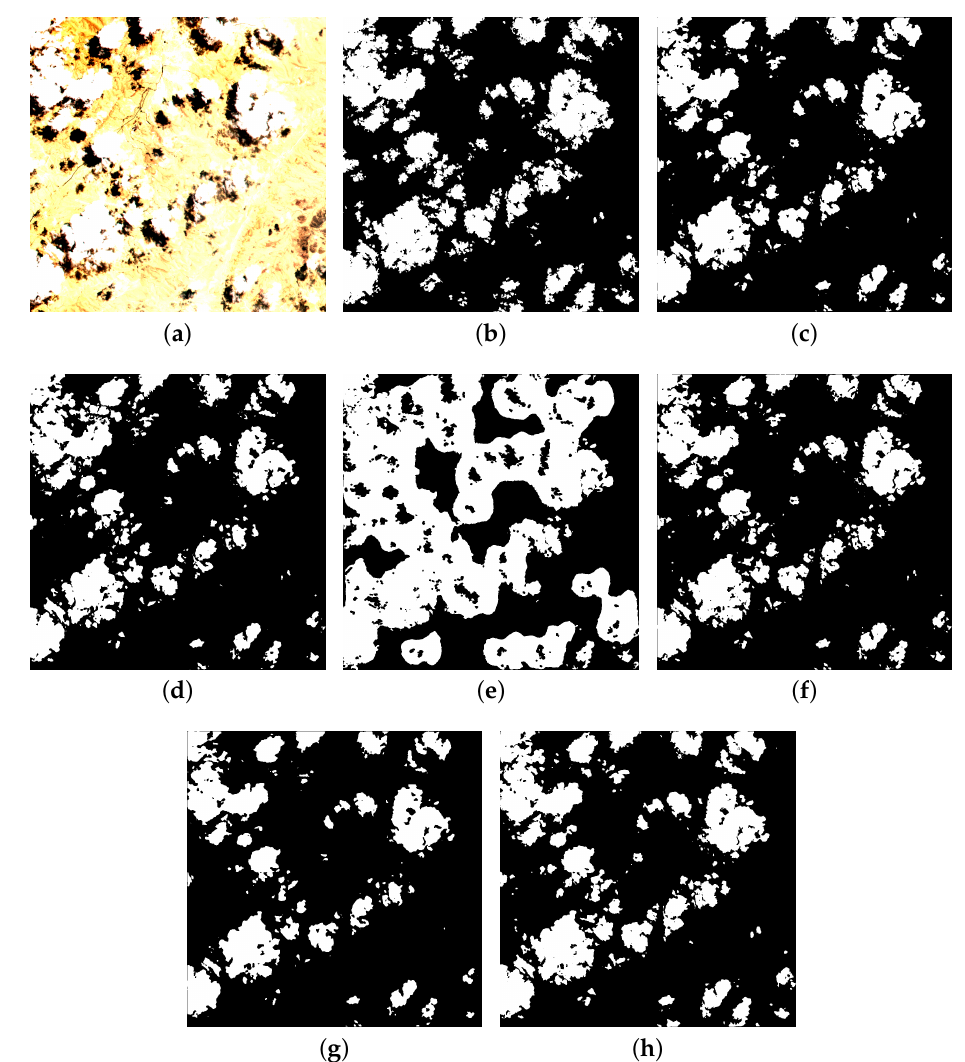
Figure 13. Binary detection of clouds on a patch of an S05 VEN µ S tile with various inputs using U-Net—Dropout 0%. ( a ) RGB representation of a patch of an S05 VEN µ S tile; ( b ) ground-truth mask; ( c ) after a training using full-band input; ( d ) using only RGB; ( e ) using RGB enhanced with NDVI; ( f ) using augmented full-band input; ( g ) using only augmented RGB; ( h ) using augmented RGB enhanced with